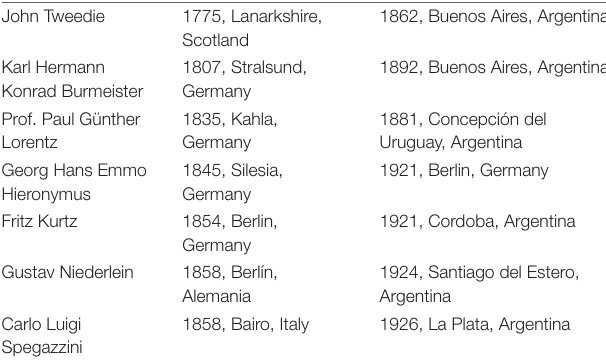
TABLE 2 | Notable European naturalist that work in Argentine Flora. TABLE 1 | List of acronyms of the mentioned herbaria, following Thiers (2019),